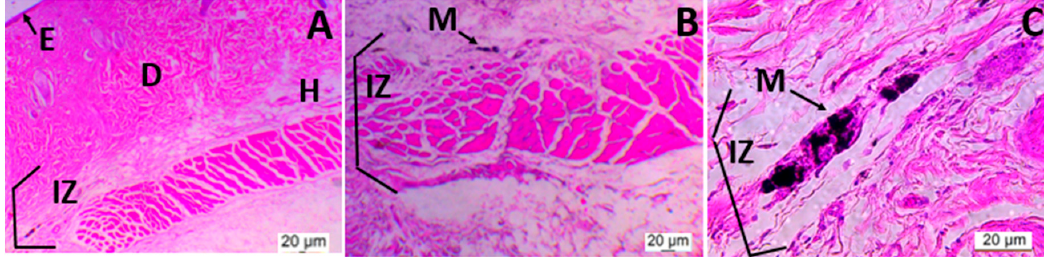
Figure 9. Histological analysis of experimental sample F1 (30 CS/70 PVA/0 ox-CNO). Magnifications are as follows: ( A ) 4×, ( B ) 10×, ( C ) 40×. E: epidermis; D: dermis; H: hypodermis; IZ: implantation zone; M: material.